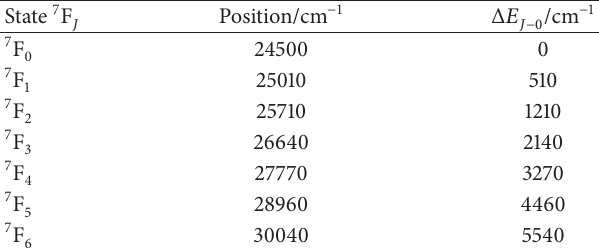
excitation 2g state. 0